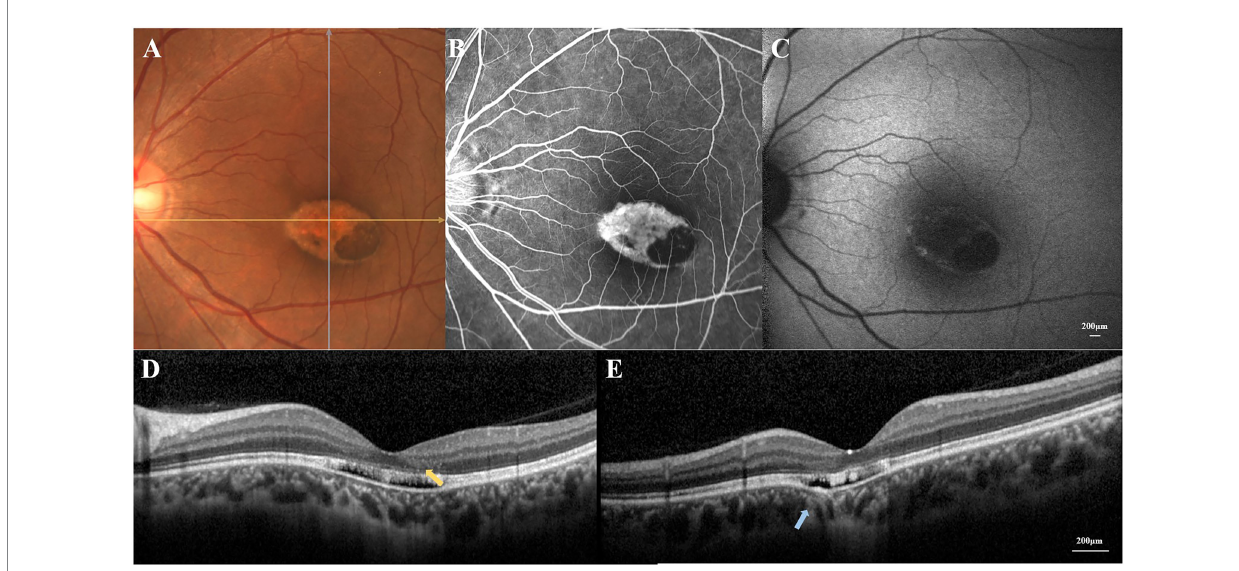
FIGURE 1 (A) Color fundus photograph revealed a well-circumscribed torpedo-like hypopigmented macula lesion. (B) Fluorescein angiography showed a corresponding window defect without leakage. (C) Fundus autofluorescence demonstrated loss of autofluorescence throughout the lesion with some hyper-autofluorescence signals along the margin. (D) The horizontal OCT scan revealed the disruption of the external retinal, the mild outer retinal cavitation, and the thinning of outer nuclear layer (yellow arrow). (E) The vertical OCT scan showed subtle inner choroidal excavation (blue arrow).